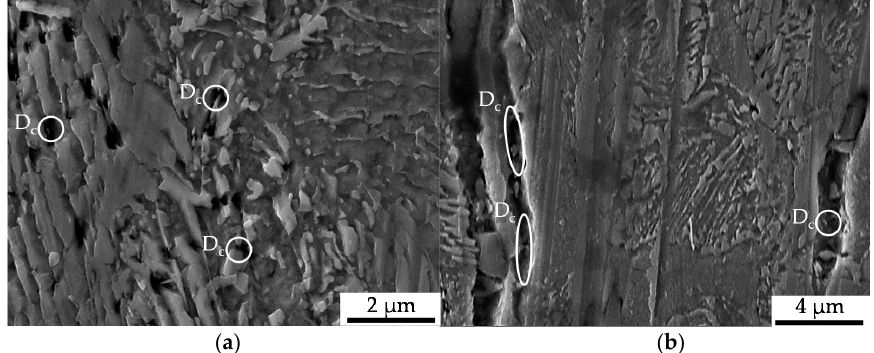
Figure 10. Cyclic damage (D c ) induced under cyclic tension load paths: ( a ) overview of the ferrite–pearlite microstructure; ( b ) detailed view of interface decohesion between the metallic matrix and MnS-inclusions.